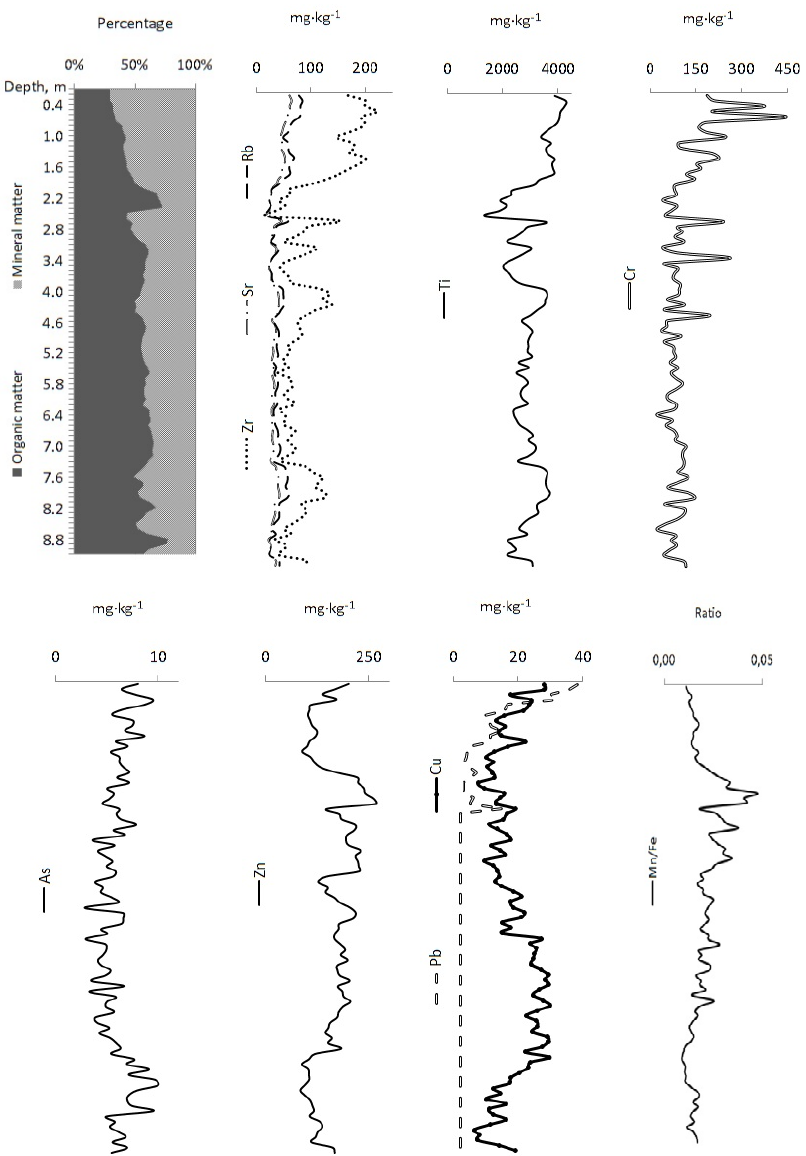
Figure 8. Main sediment components and concentrations of heavy metals in sediments from Lake Gineitišk ė s.